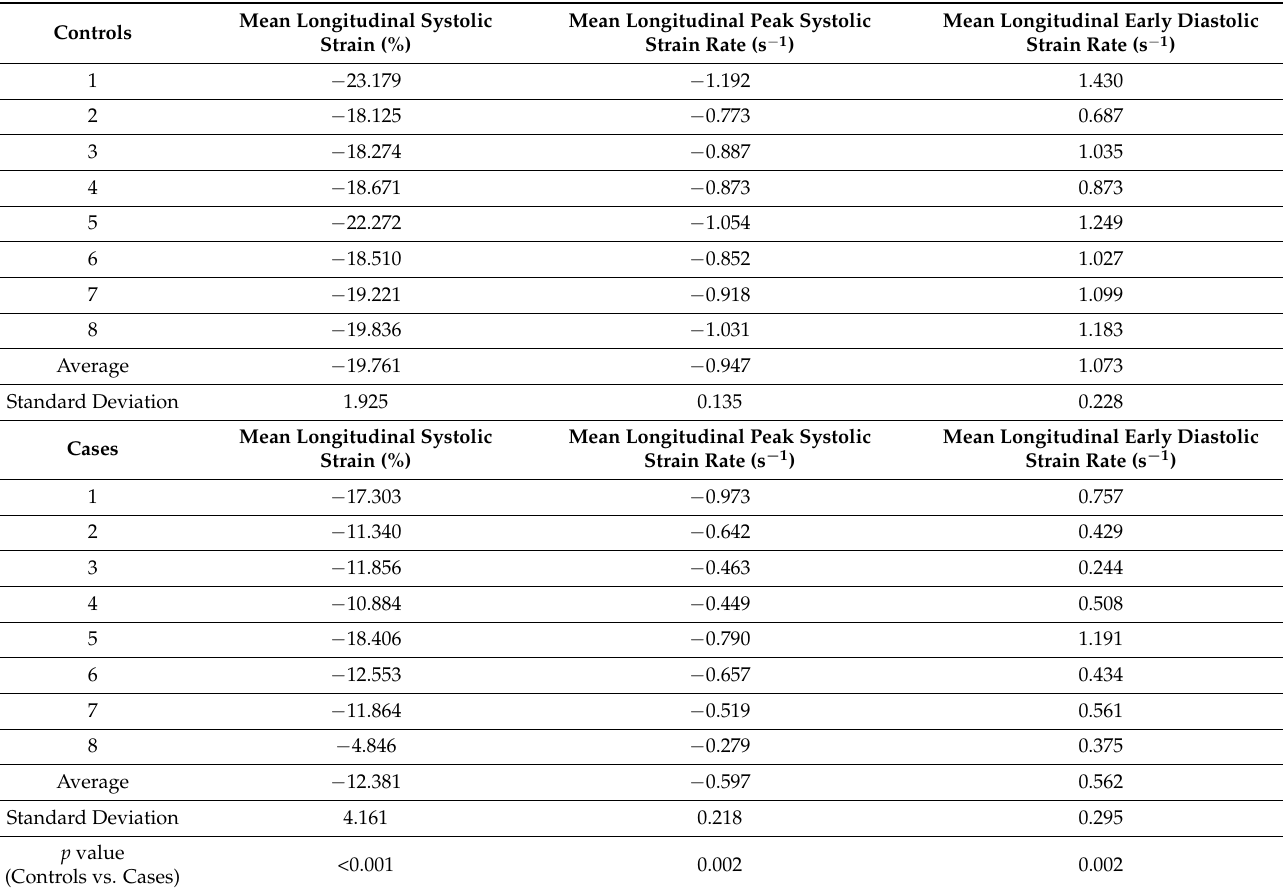
Figure 2. Strain curves illustrating changes in left ventricular (LV) longitudinal strain and strain rate over the course of one cardiac cycle. Strain curves were generated by averaging individual strain curves calculated at each time point. n = 8 normal and immune checkpoint inhibitor (ICI)-treated patients. ( A ). LV, longitudinal strain curves; ( B ). LV, longitudinal strain rate curves. SR S = peak systolic strain rate; SR E = early diastolic strain rate. Table 4. Echocardiographic strain indices of cases vs.